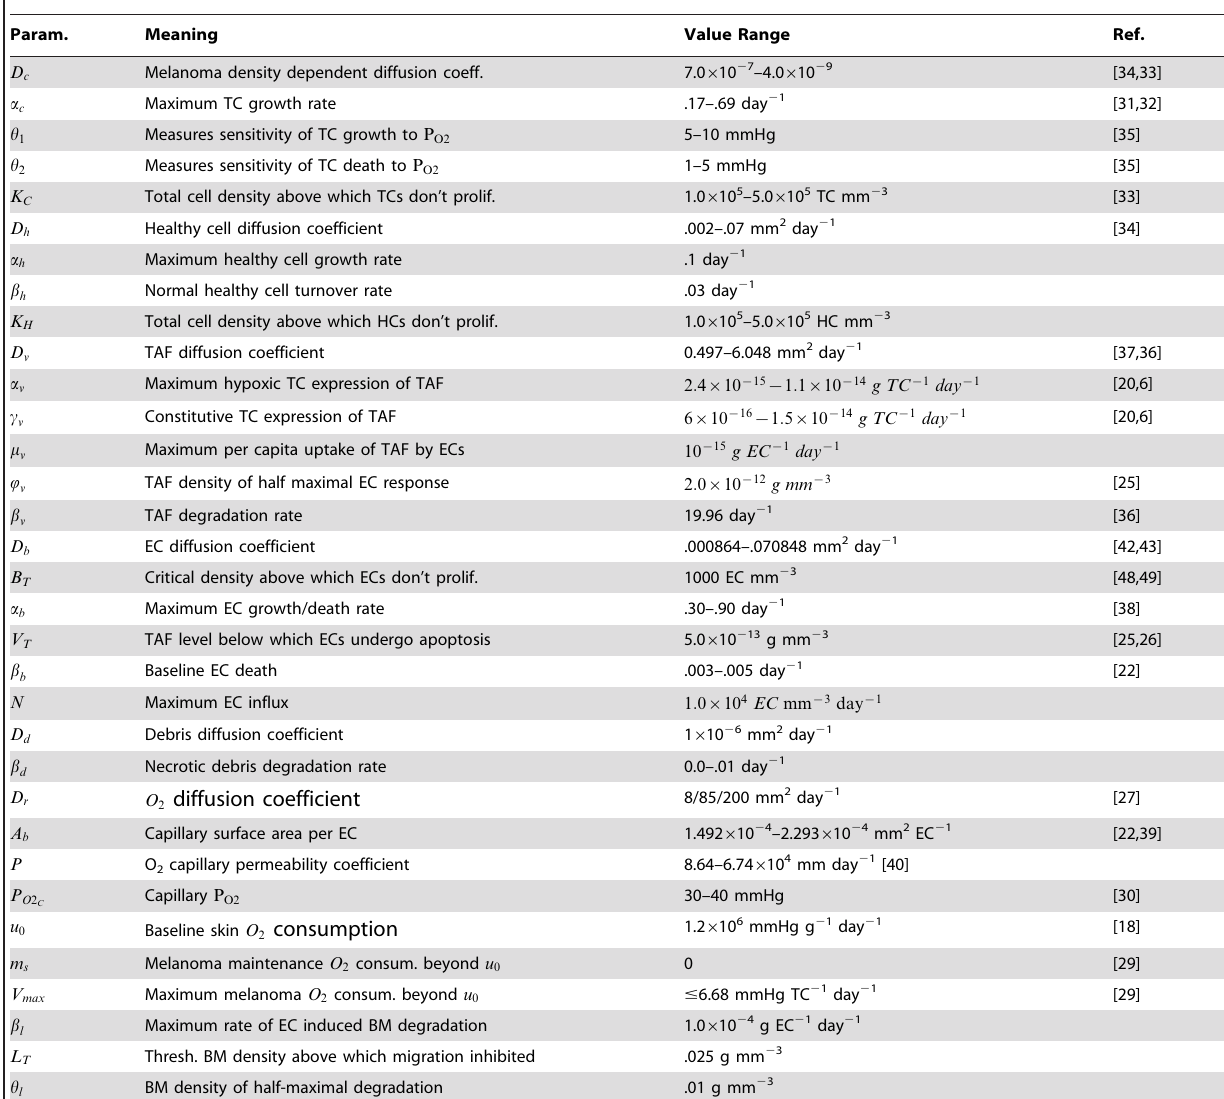
Table 1. Parameters and values for the basic model.